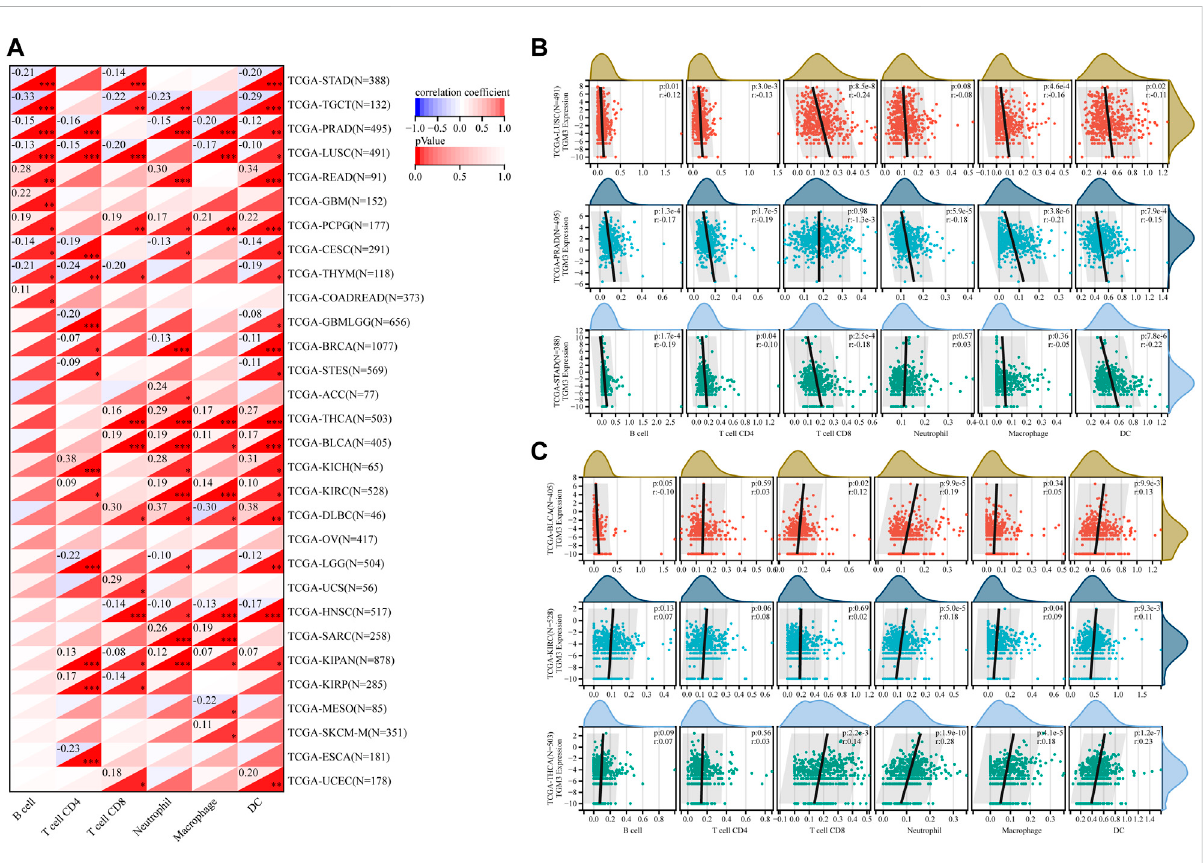
FIGURE 6 (A) Based on the TIMER database, the correlation between TGM3 expression and tumor-in fi ltrating immune cells was demonstrated. (B) Negative correlation between TGM3 mRNA expression and six immune cell in fi ltration scores in LUSC, PRAD and STAD. (C) Positive correlation between TGM3 mRNA expression and six immune cell in fi ltration scores in BLCA, KIRC and THCA. * p < 0.05, ** p < 0.01, and *** p <